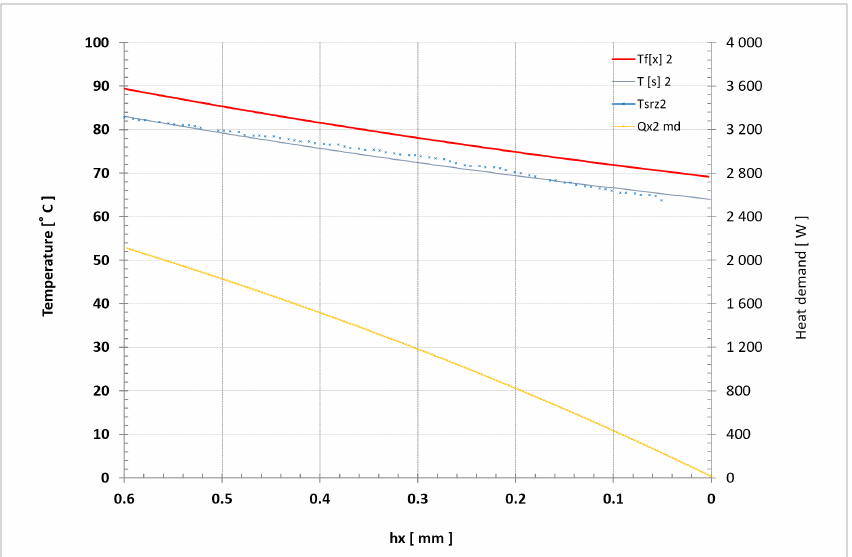
Figure 23. Delonghi -22 comparison of measurement and calculations results of water temperature, radiator surface temperature and radiator heat out distribution—measurement 1, t s = 89.8 ◦ C, t r = 75.9 ◦ C, t i = 19.9 ◦ C, q mx = 0.0379 kg/s, ( q m . max ) .